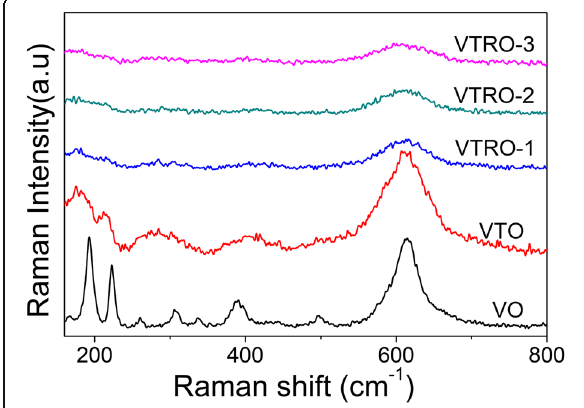
Fig. 4 Room-temperature Raman spectra for undoped VO 2 , Ti- doped VO 2 and V 1-x-y Ti x Ru y O 2 thin